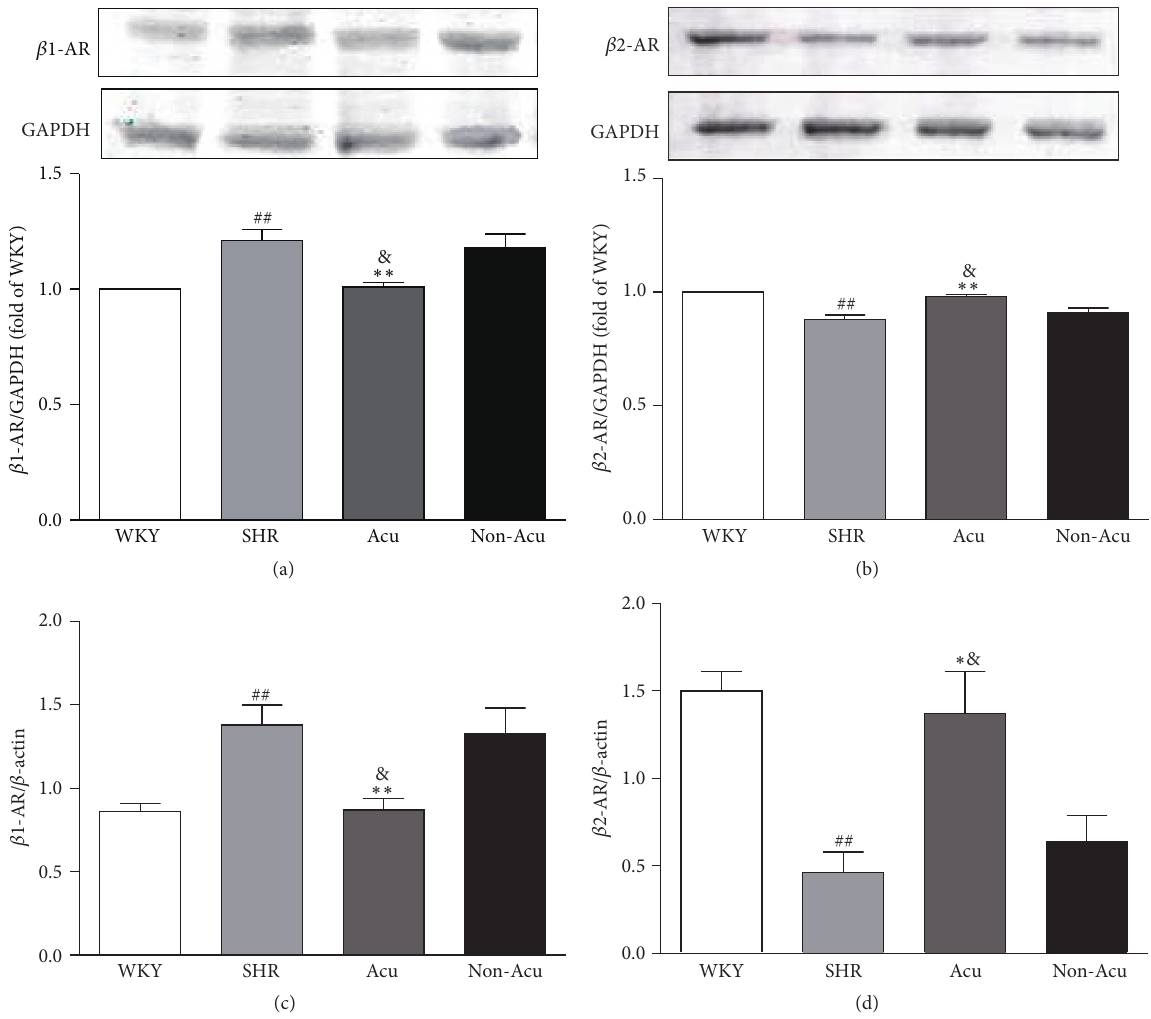
Figure 3: Effects of acupuncture on renal protein expression of 𝛽 1-AR (a), 𝛽 2-AR (b) and mRNA expression of 𝛽 1-AR (c), 𝛽 2-AR (d) in all groups. Data are presented as mean ± SEM ( 𝑛 = 10 rats). ## indicate 𝑃 < 0.01 , compared with the WKY group; ∗ and ∗∗ indicate 𝑃 < 0.05 and 𝑃 < 0.01 , respectively, compared with SHR group; & indicate 𝑃 < 0.05 , compared with Non-Acu